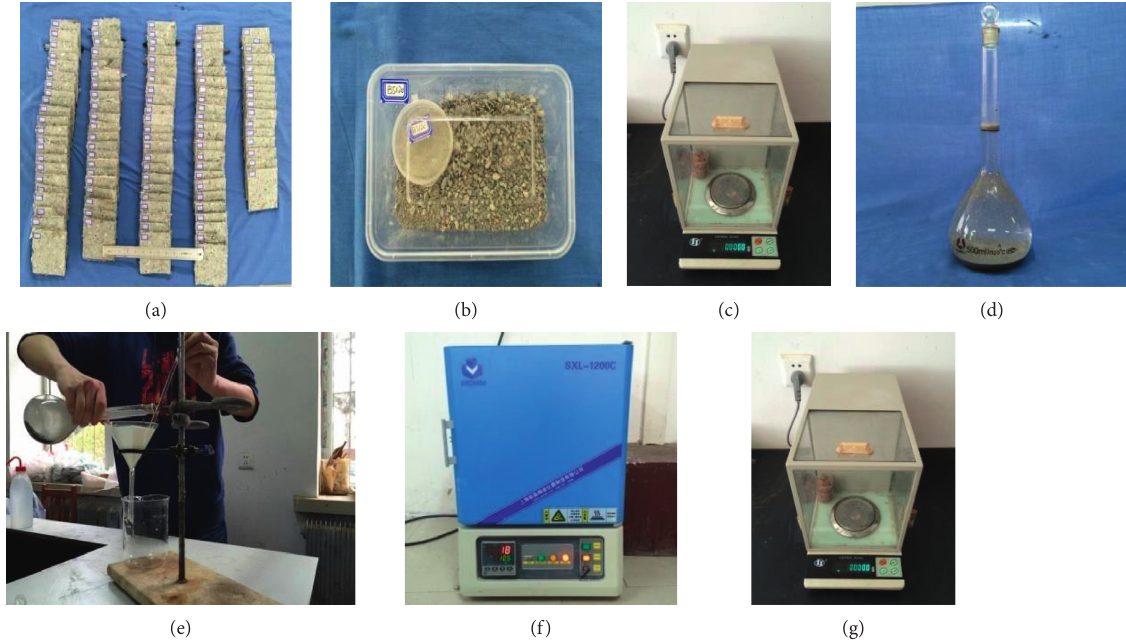
Figure 5: Experiment procedures of sulfate ion content test in concrete. (a) Cut. (b) Collected powder. (c) Weighing of powder. (d) Extraction. (e) Collection of precipitate. (f) High-temperature stove. (g) Weighing of the